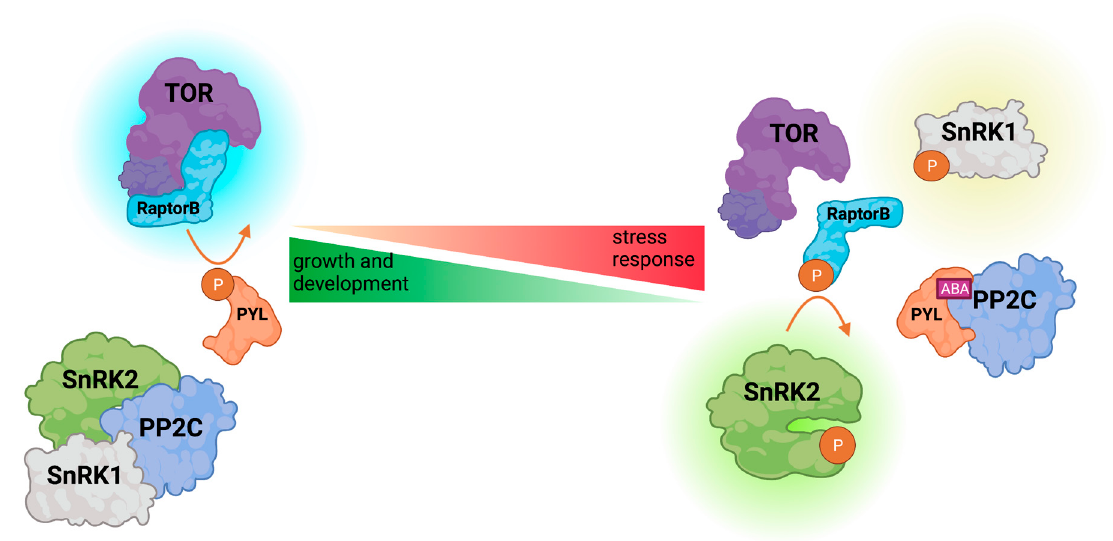
Figure 3. Schematic illustration of the TOR-SnRK-dependent growth/stress response balance regulation in Arabidopsis. Under favorable conditions, active TOR (Target of Rapamycin) kinase complex phosphorylates PYL, compromising its interaction with PP2C phosphatase, leading to SnRK inactivation. Upon stress, abscisic acid (ABA) enables PYL-PP2C interaction, thus releasing SnRK from inhibition. Active SnRK phosphorylates RaptorB, rendering TOR inactive. Active kinases are indicated by a bright